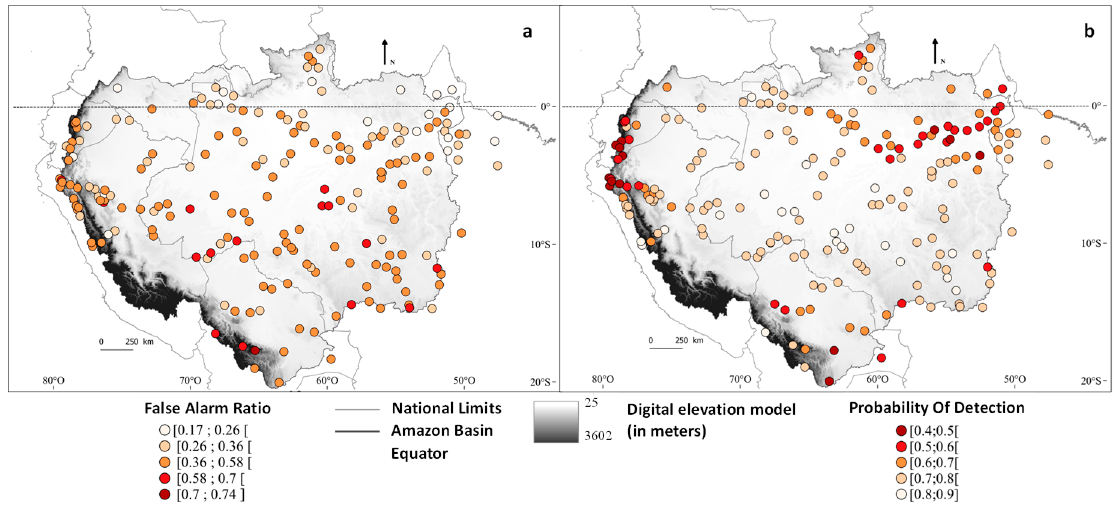
Figure 5. Spatial distribution of ( a ) the probability of detection and ( b ) the false alarm ratio. Both are calculated from 2000 to 2013 at daily time scale.